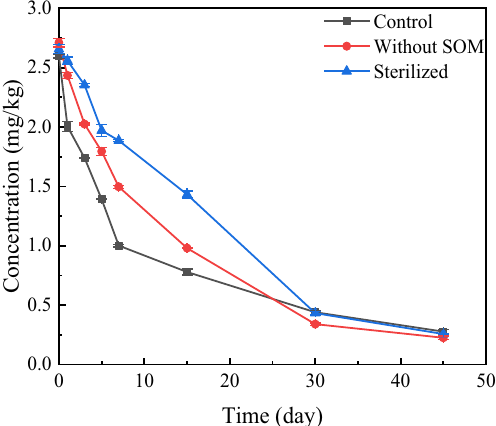
Figure 6. Degradation of propaquizafop in sterilised and organic matter-removed soil.